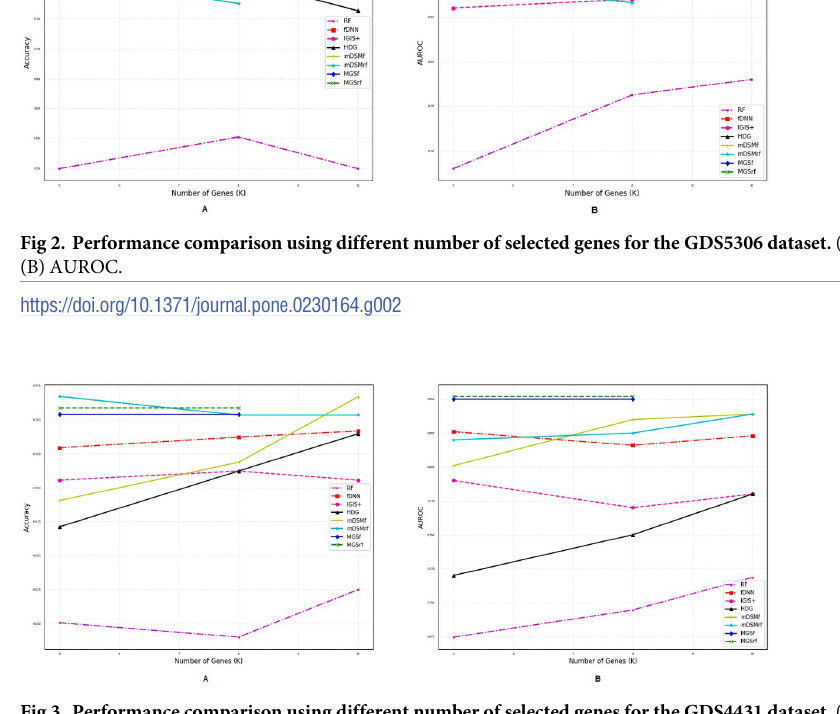
Fig 3. Performance comparison using different number of selected genes for the GDS4431 dataset. (A) Accuracy. (B) AUROC.